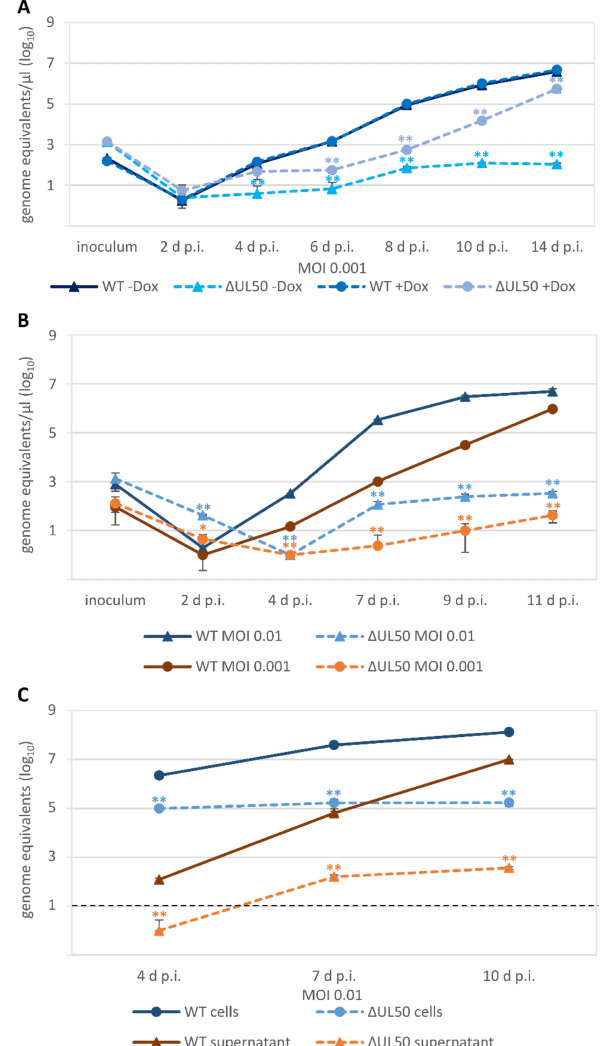
Figure 5. HCMV replication kinetics of the ORF-UL50 deletion mutant. HFF-UL50 cells ( A ) or HFFs ( B , C ) were infected with parental HCMV AD169 (WT) or recombinant HCMV ∆ UL50 at a MOI of 0.01 or 0.001 as indicated. The expression of pUL50 in HFF-UL50 cells was either uninduced ( − Dox) or induced (+Dox). Viral supernatants ( A – C ) or cells ( C ) were harvested at the indicated time points and viral genome equivalents were determined by IE1-specific ddPCR ( A , B ) or qPCR ( C ). Each infection was performed at least in triplicates; mean values and standard deviations are shown. The significance is calculated relating to WT (solid lines). The standard containing 10 HCMV DNA copies reached the cycle threshold at cycle 38 and was therefore defined as the limit of detection for qPCR, as shown by the black dashed line. ddPCR is a binary end-point measurement and can detect one single copy; *, p ≤ 0.05; **, p ≤